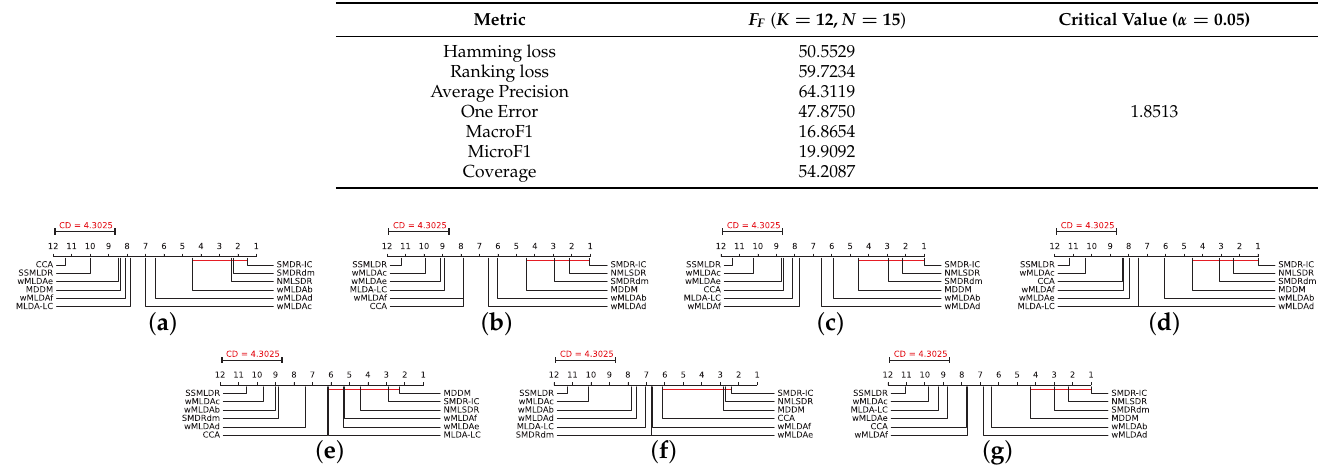
Table 5. Friedman statistics F F and the critical value of each evaluation metric.